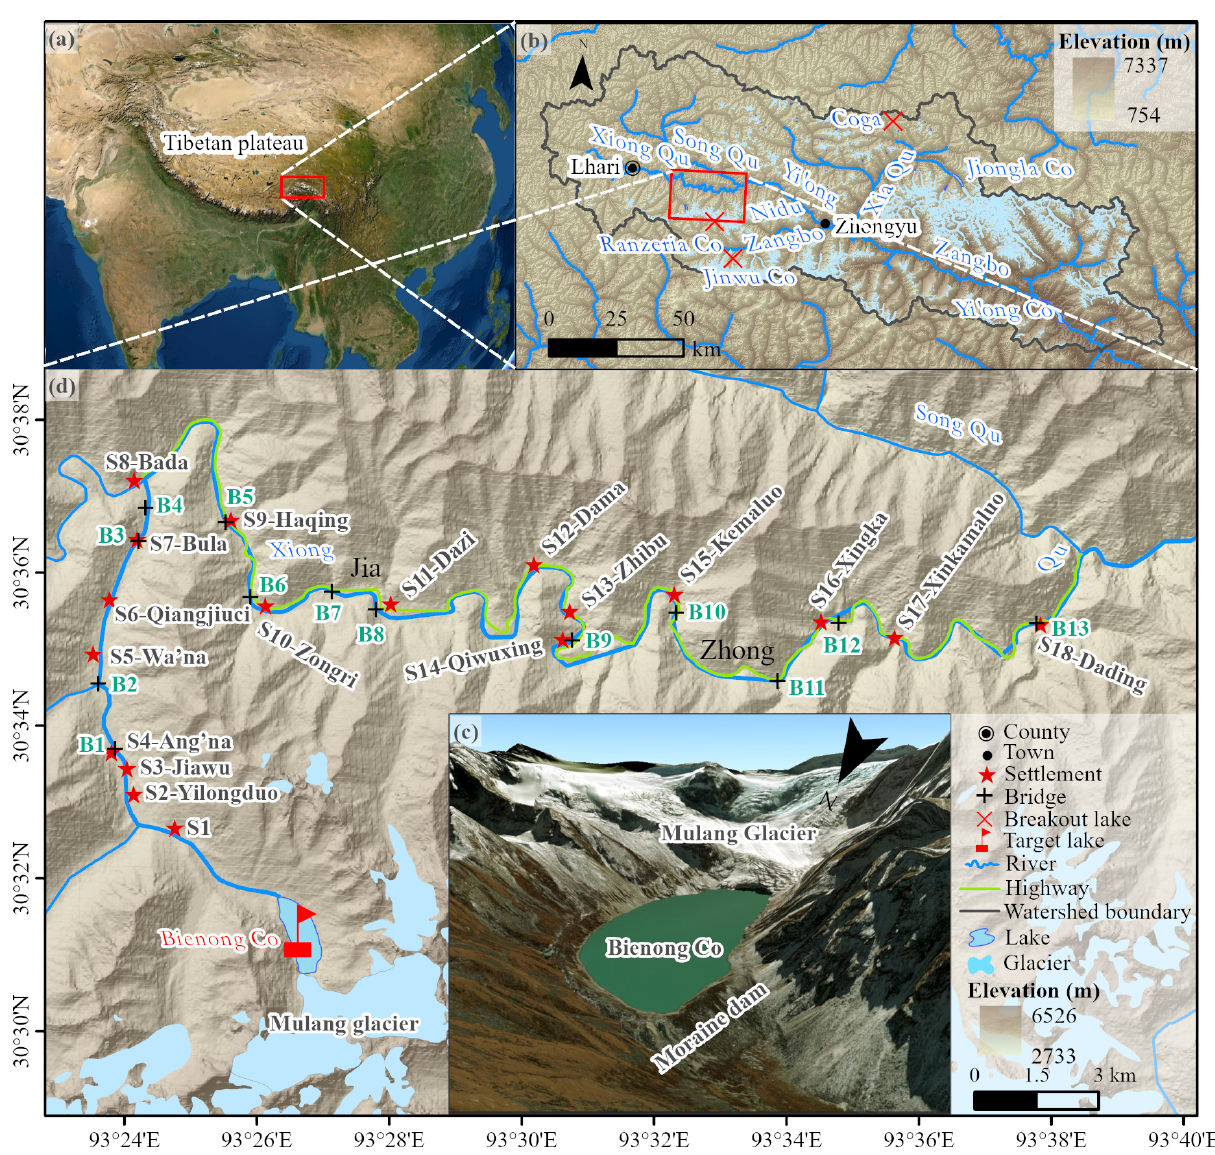
Figure 1. Overview of the study area. (a) The location of the Yi’ong Zangbo basin, (b) the location of Bienong Co, (c) a close view of Bienong Co, and (d) the distribution of settlements and bridges within ∼ 53km downstream of Bienong Co. The background of panels (a) and (c) is a MapWorld image, based on which settlements, bridges, and the Jiazhong highway along the flow channel are identified. The background of panels (b) and (d) is the Advanced Land Observing Satellite (ALOS) Phased Array type L-band Synthetic Aperture Radar (PALSAR) digital elevation model